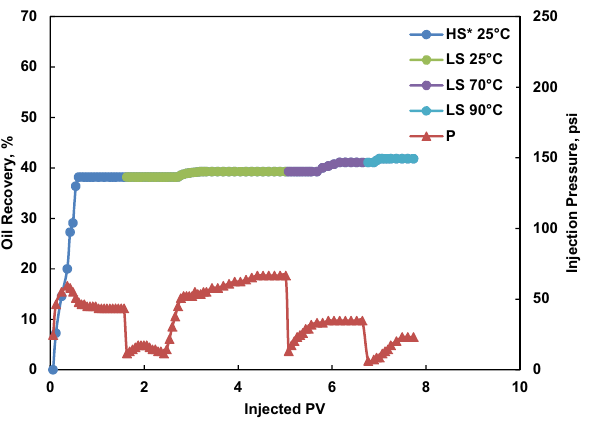
Fig. 6 Oil recovery factor and pressure profile for core#3, which was sequentially flooded by HS water/LS water at 25, 70, and 90 °C